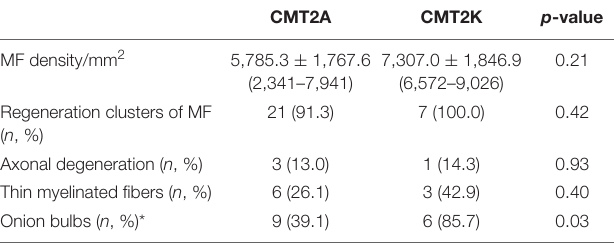
TABLE 3 | Pathological features of the patients with CMT2A and CMT2K. CMT2A CMT2K